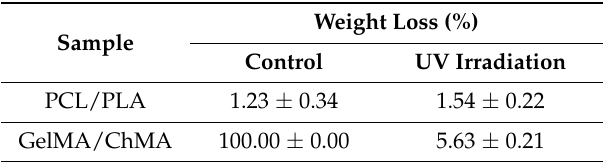
Table 1. Assessed values of weight loss (%) for both the protective (PCL/PLA) and underlying layer (GelMA/ChMA) of the asymmetrical membranes.